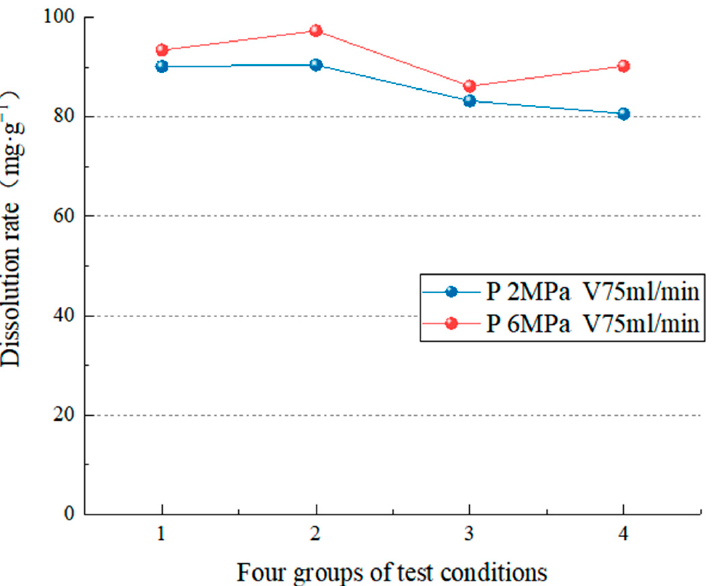
Figure 10. Comparison of the dissolution rate at a water flow velocity of 75 mL/min.